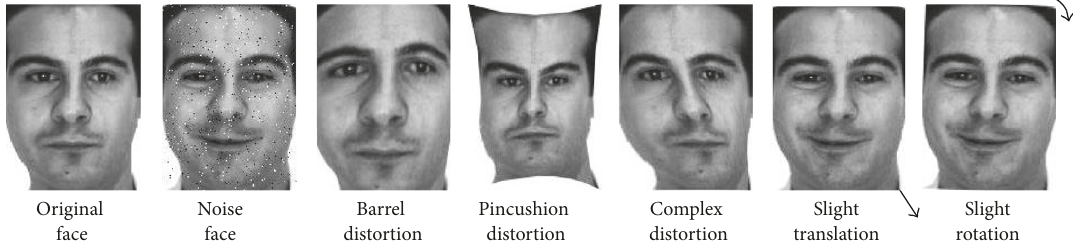
Figure 1: Face samples suffering from noise, geometric distortions, slight translation, and rotation changes on AR face